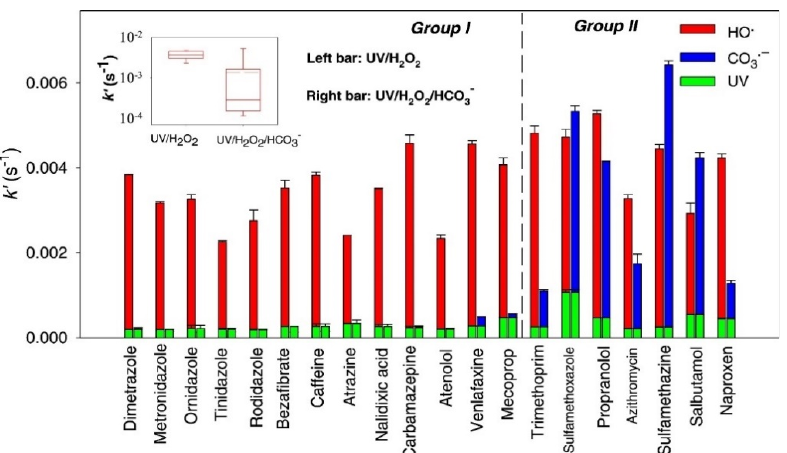
Figure 3. The e ff ect of CO 32 − on the rate of degradation of various pharmaceutical pollutants using Figure 3. The effect of CO 3 2 − on the rate of degradation of various pharmaceutical pollutants using the UV/H 2 O 2 photolysis method. Reprinted with permission from [61]. the UV/H 2 O 2 photolysis method. Reprinted with permission from Table 2. The bimolecular rate constants for the reaction of CO 3  - with some pharmaceuticals [61].